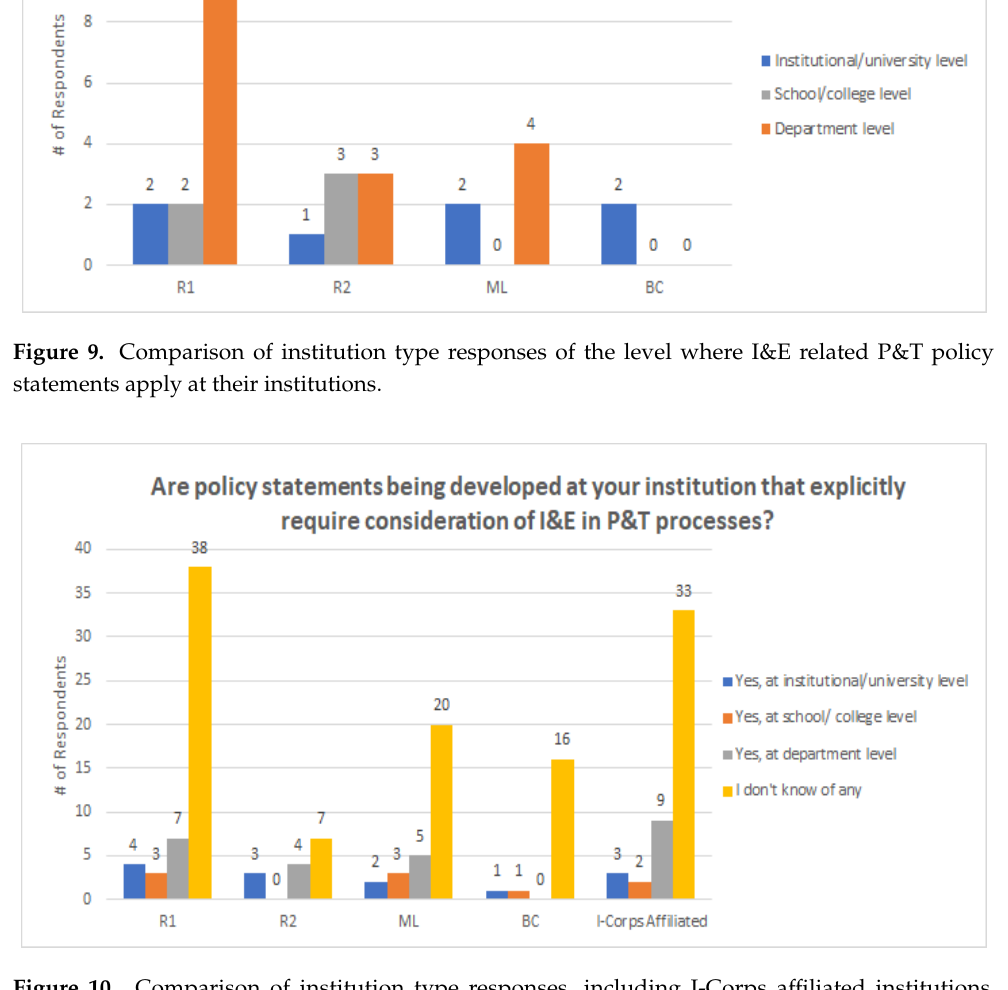
Figure 10. Comparison of institution type responses, including I-Corps affiliated institutions, whether policy statements are being developed that require consideration of I&E in P&T processes at their institutions.